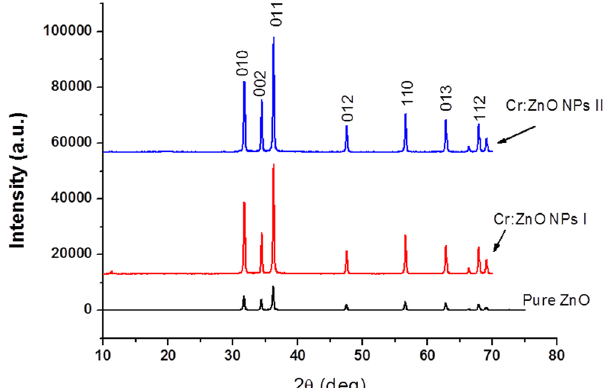
Figure 1. XRD powder of reagent grade zinc oxide powder, 2 mole% Cr:ZnO NPs (І), and 5 mole% Cr:ZnO NPs (П).